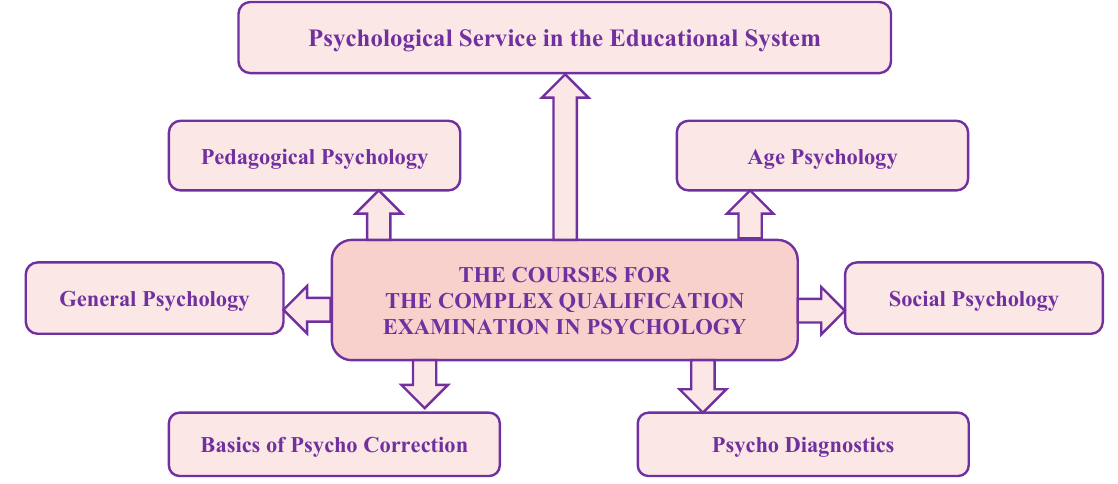
Figure 1. The courses for the complex qualification examination in Psychology for the future specialists.